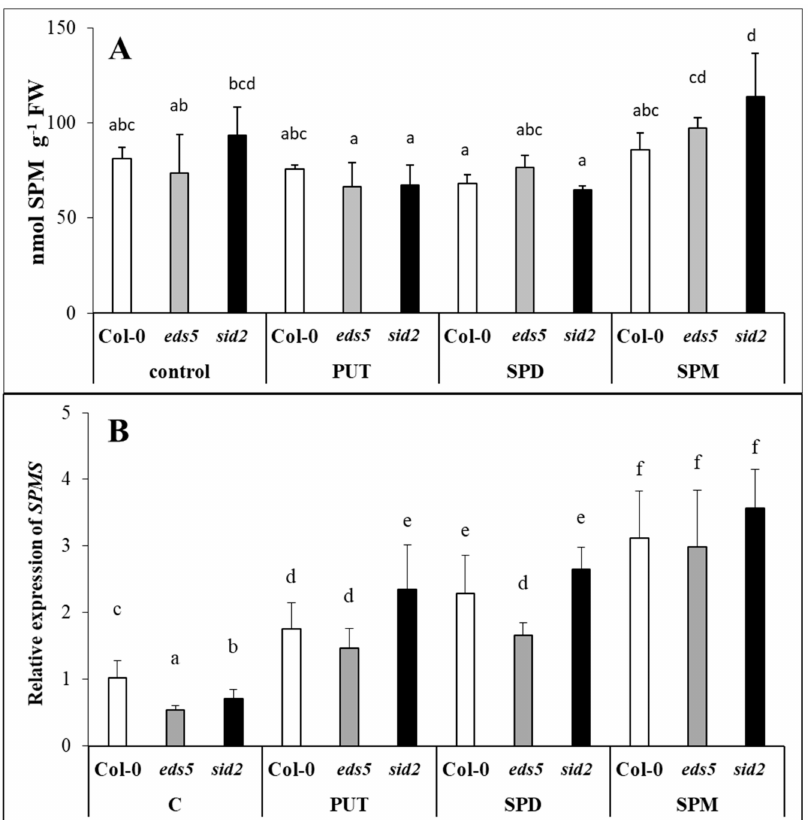
Figure 4. E ff ect of 0.5 mM 1-day of putrescine (PUT), spermidine (SPD) and spermine (SPM) treatments on spermine content (( A ) SPM) and on the expression levels of spermine synthase gene (( B ) SPMS ) in Col-0, wild type, eds5-1 ( eds5 ) and sid2-2 ( sid2 ) Arabidopsis mutants. Data represent mean values ± SD. Di ff erent letters indicate significant di ff erences at p ≤ 0.05